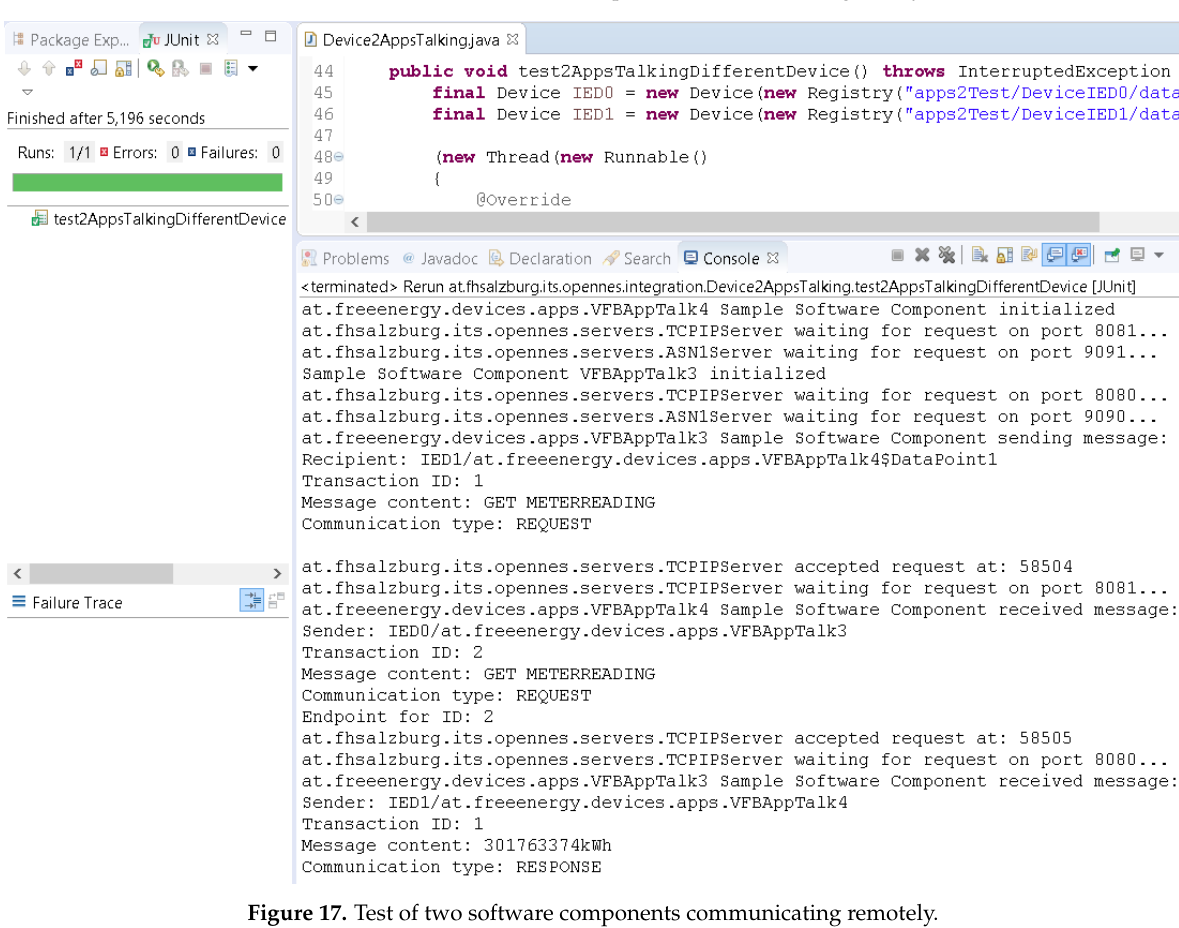
Figure 16. Test of two software components communicating locally.